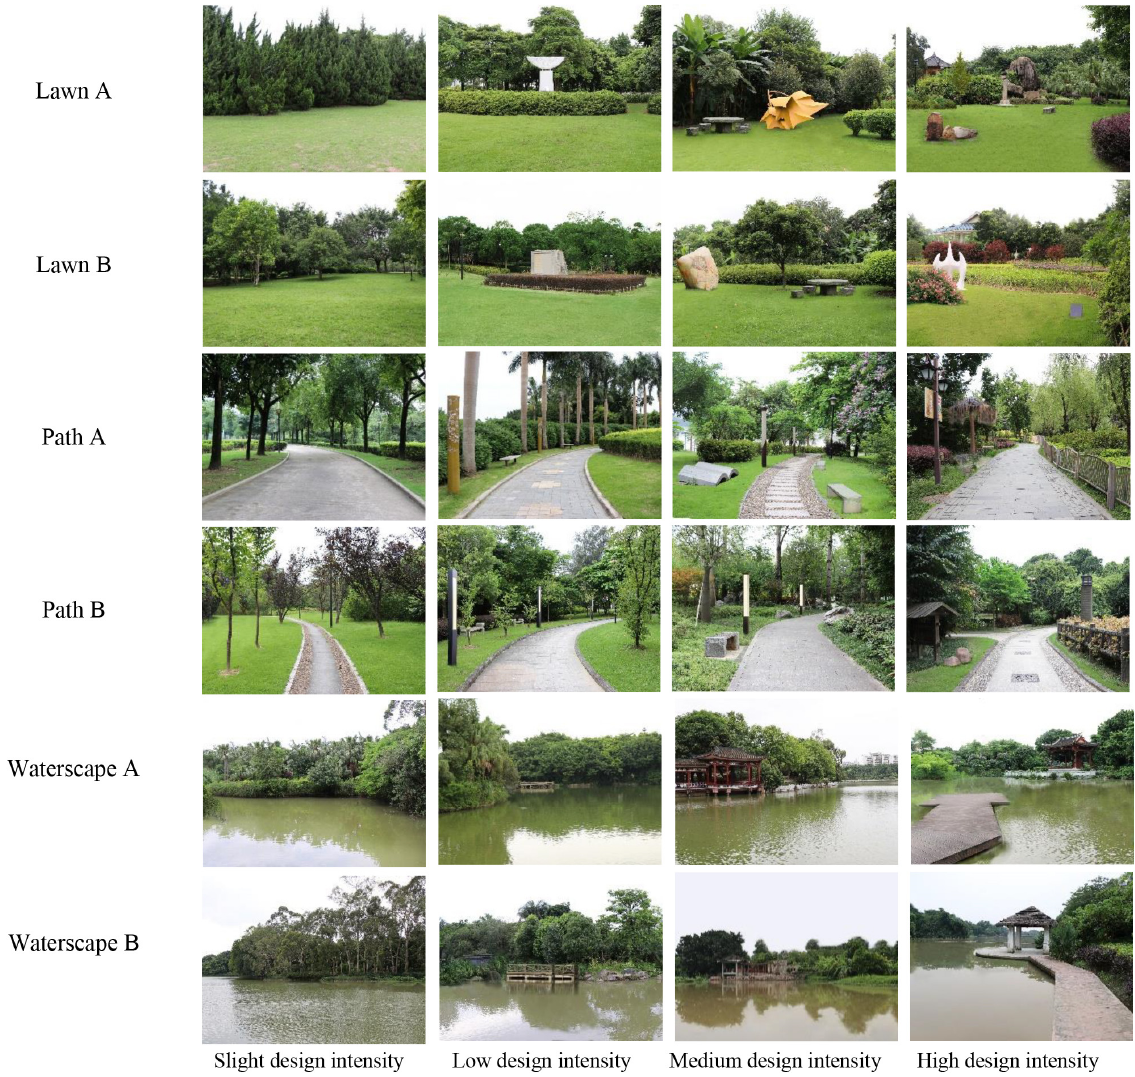
Figure 1. Presentation of the stimuli.